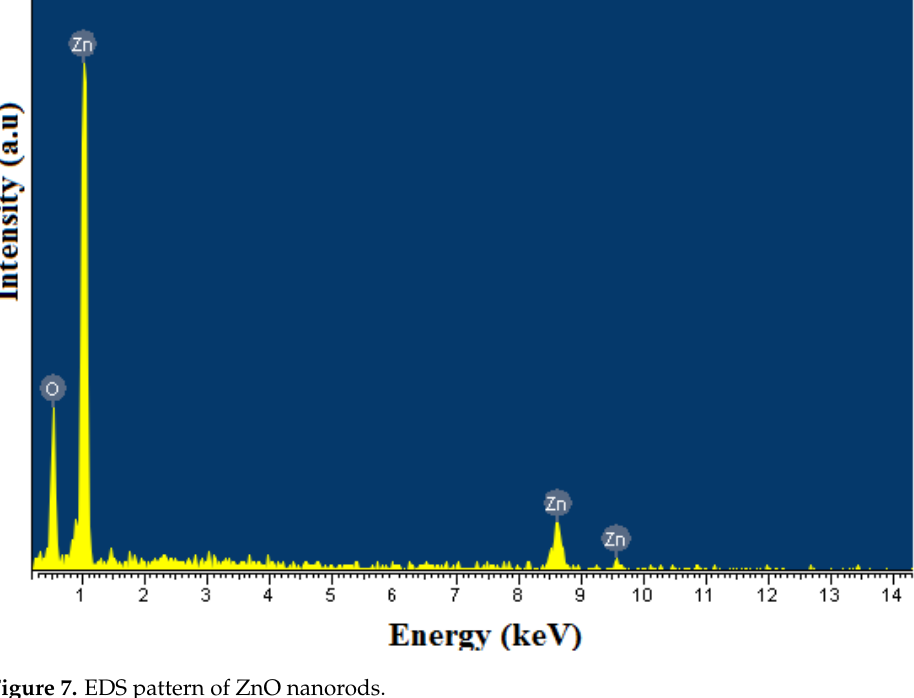
Figure 6. Results XRD patterns of ZnO.